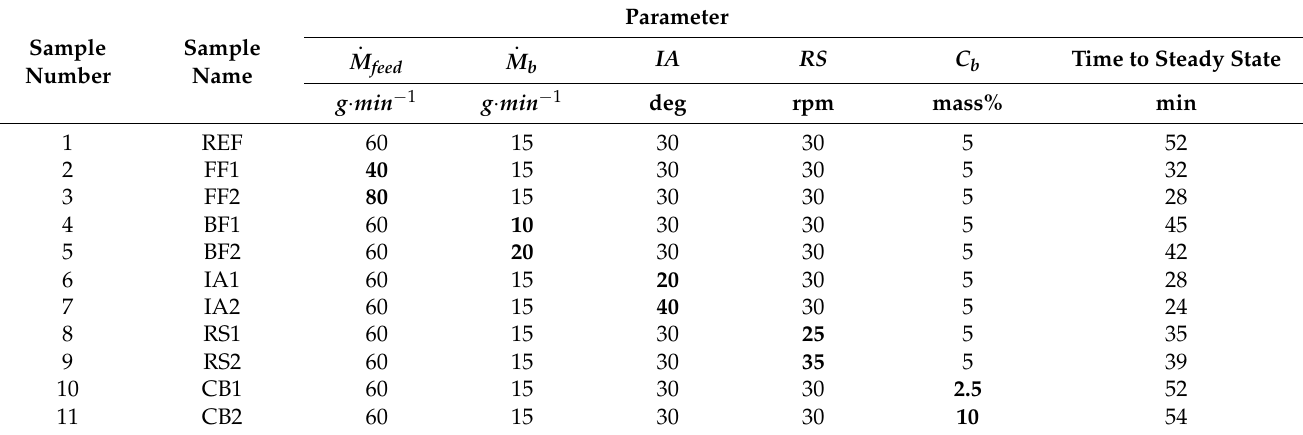
Table 1. Experimental plan for the variation of the operation parameters (varied parameters indicated bold).